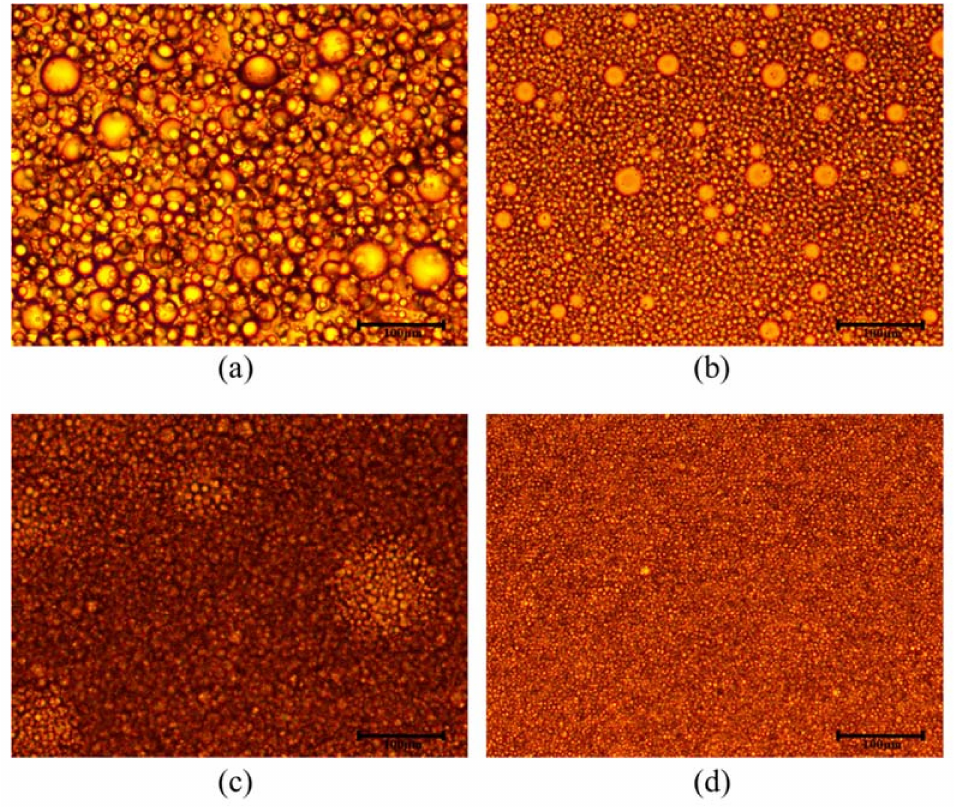
Figure 5. Optical microscopic image of emulsion with different content Tween80: ( a ) 0%; ( b ) 0.5%; ( c ) 1.0%; ( d ) 2.0%.